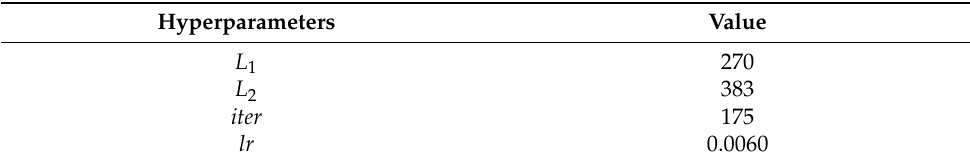
Table 4. The result of SSA search for hyperparameters.